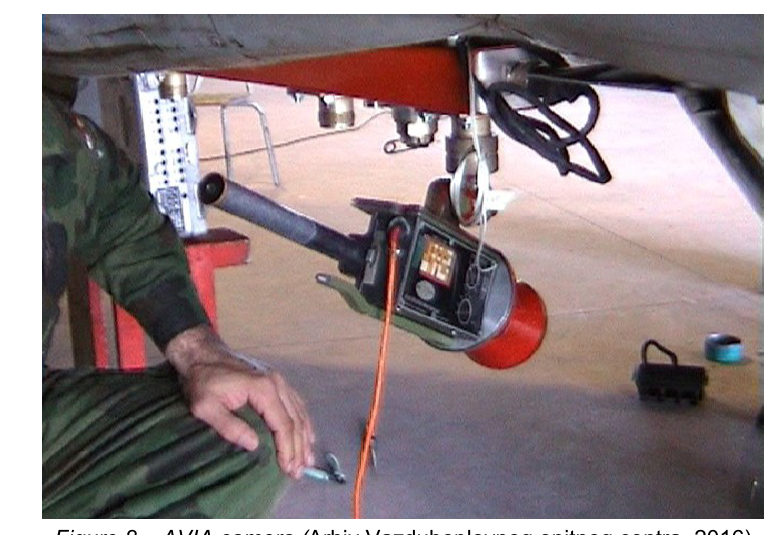
Figure 8 – AVIA camera ( Arhiv Vazduhoplovnog opitnog centra, 2016) Рисунок 8 – AVIA камера ( Arhiv Vazduhoplovnog opitnog centra,